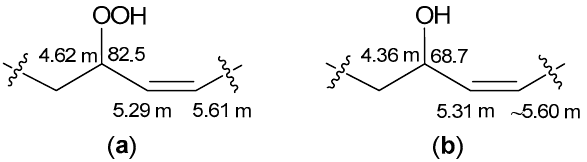
Figure A1. Some δ H (500 MHz) and δ C (125 MHz) values for trace cis -monoenes with allylic ( a ) hydroperoxy or ( b ) hydroxy groups (solvent: CD 3 OD).